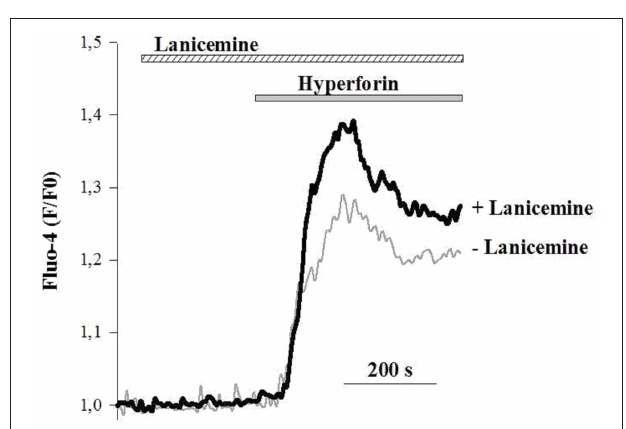
FIGURE 8 | Representative Ca 2 + responses from 2 different cells in response to the application of 1 µ M hyperforin alone (gray line) and 4min after the addition of 5 µ M Lanicemine (black line). Note that Lanicemine remained during stimulation with hyperforin. n = 112 and 126 cells with hyperforin and hyperforin + Lanicemine, respectively. Hyperforin-induced Ca 2 + responses were increased by 35 ± 6 % ( p < 0.05, Student’s t -test) by a 4min pre-incubation with